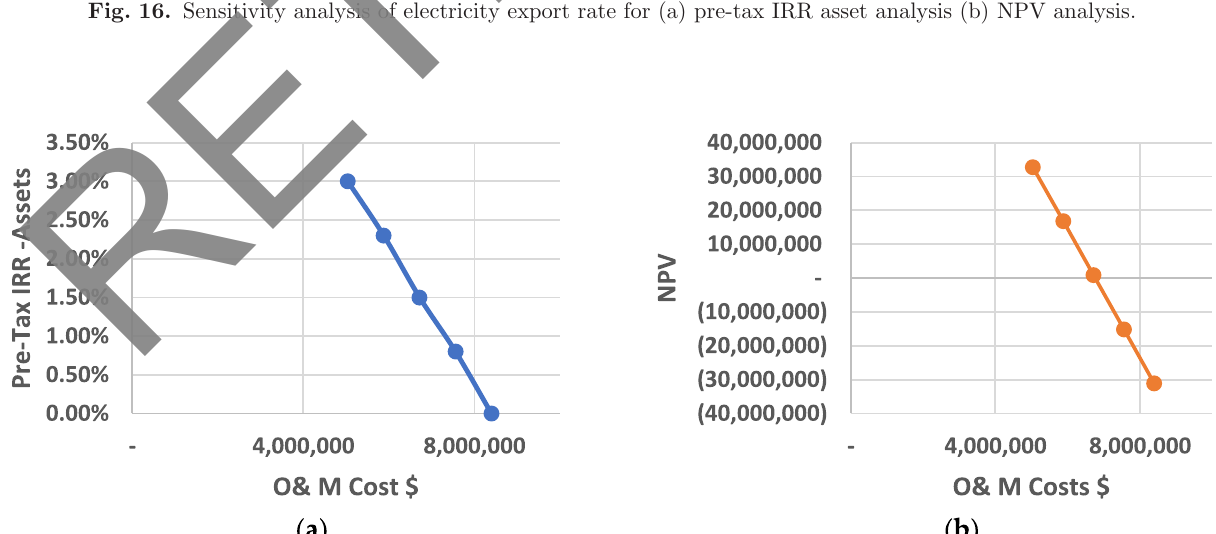
Fig. 16. Sensitivity analysis of electricity export rate for (a) pre-tax IRR asset analysis (b) NPV analysis.